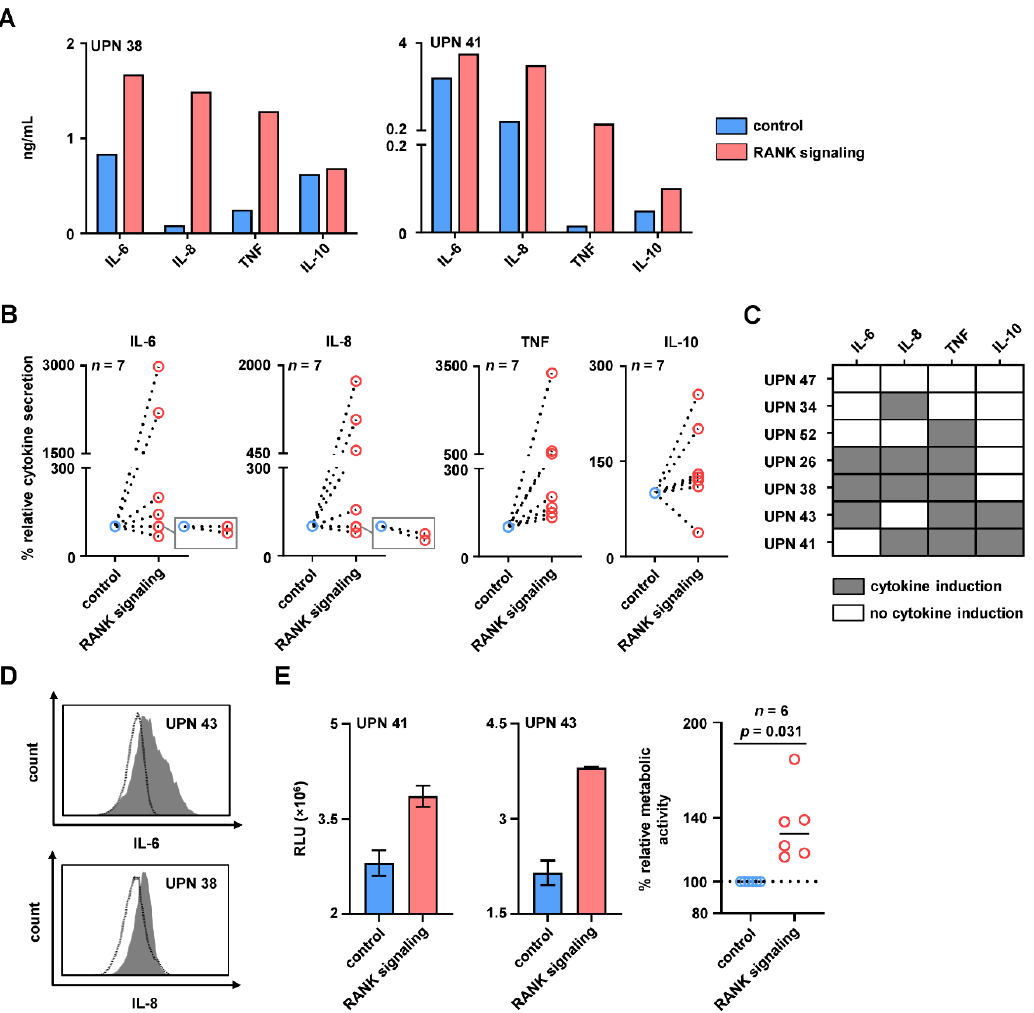
Figure 2. Induction of cytokines and metabolic activity upon RANK signaling in primary AML cells. PBMC of AML patients were cultured with Fc-hRANKL or rhIgG1-Fc as isotype control. ( A – C ) The levels of IL-6, IL-8, TNF and IL-10 in culture supernatants were determined by LEGENDplex TM assay after 24 h. ( A ) Exemplary data on the induction of IL-6, IL-8, TNF and IL-10 in culture supernatants of 2 AML patients are depicted. ( B ) Combined data of the cytokine release in n = 7 patients normalized to the isotype control are shown and individual patients are connected by dotted lines. ( C ) Patient-specific cytokine induction pattern upon RANK signaling is shown as heatmap representation (grey, cytokine induction; white, no cytokine induction). ( D ) Intracellular cytokine levels of IL-6 and IL-8 in 2 exemplary AML patients were analyzed by flow cytometry (shaded peaks, intracellular IL-6/IL-8; open peaks, isotype control). ( E ) Metabolic activity of leukemic cells was determined by CTG assay after 24 h. Results of representative experiments (left 2 panels) as well as combined results (right panel) obtained in independent experiments with leukemic cells of n = 6 AML patients are depicted (solid line, median; dotted line, 100% relative metabolic activity). Numbers in panels, heatmap and histograms represent uniform patient number (UPN) as shown in Table